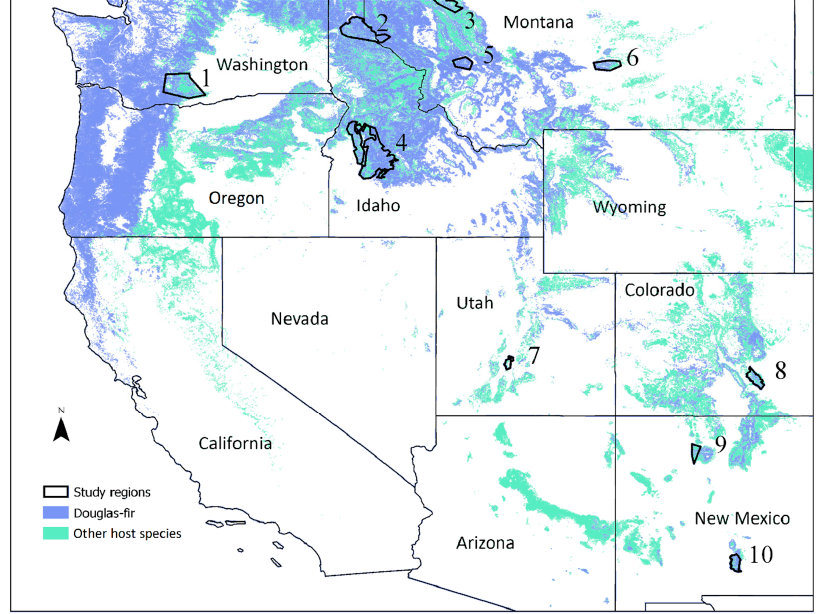
Figure 1. Ranges of host tree species of western spruce budworm (light blue for Douglas-fir and light green for other host species) and regions analyzed in this study (polygons and numbers).